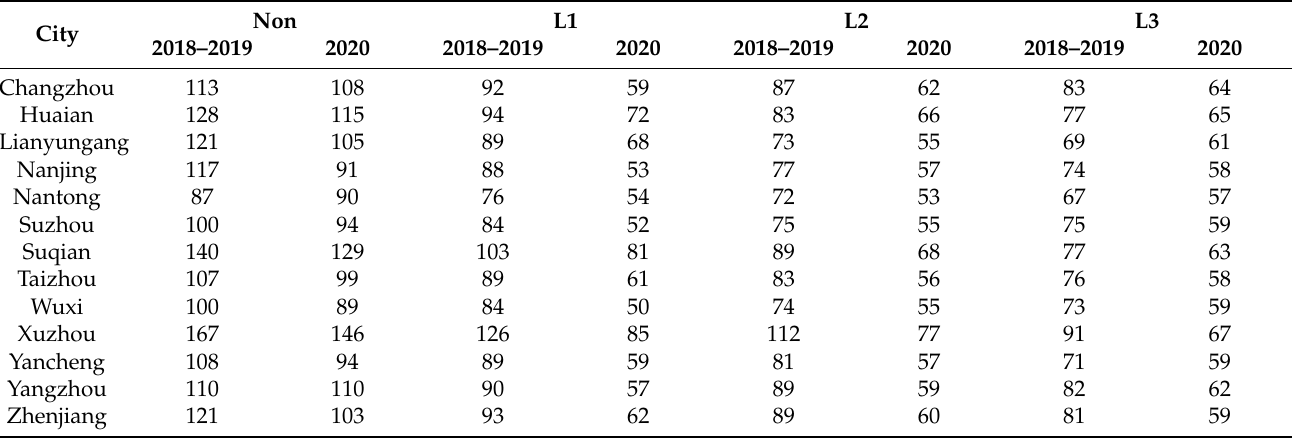
Table 4. Variations of AQI in 13 prefecture-level cities of Jiangsu under different levels of pandemic prevention and control measures, and those in the same period of historical years (the data are consistent with Figure